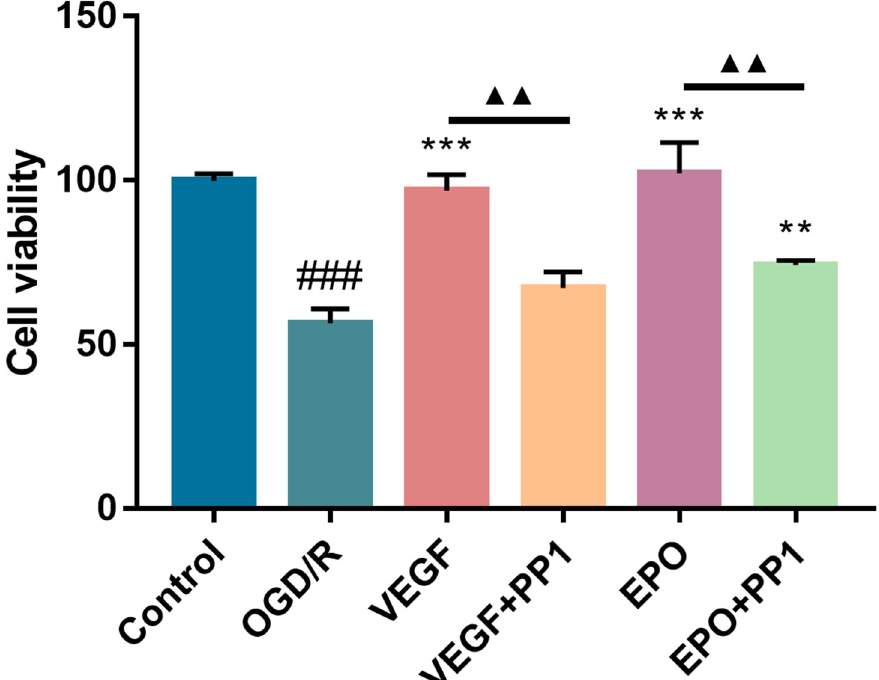
Fig 4. EPO and VEGF proteins enhance the viability of bEnd.3 cells after OGD/R. An oxygen-glucose deprivation/ reoxygenation (OGD/R) model was established in vitro . The bEnd. 3 cells were divided into 6 groups; control, OGD/R, VEGF, VEGF + PP1, EPO and EPO + PP1 groups. The control group did not experience OGD/R injury. The quantitative results of the cell viability in each group were obtained from three independent experiments. Data were expressed as mean ± SEM. ### P < 0.001 vs. control group; �� P < 0.01, ��� P < 0.001 vs. OGD/G group.